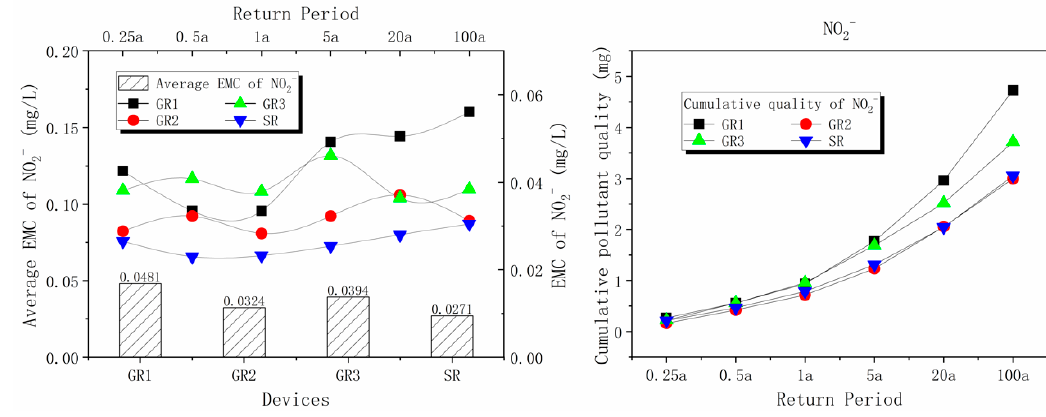
Figure 4. EMC and cumulative pollutant quality of NO 2 − .